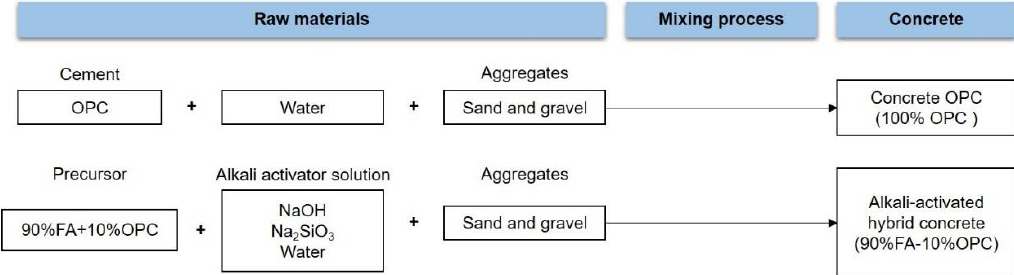
Figure 15. Production process of alkali-activated hybrid concrete (90% FA–10% OPC) vs. 100% OPC-based conventional concrete. Table 8. Inventory of emissions and impacts associated with raw materials of alkali-activated hybrid